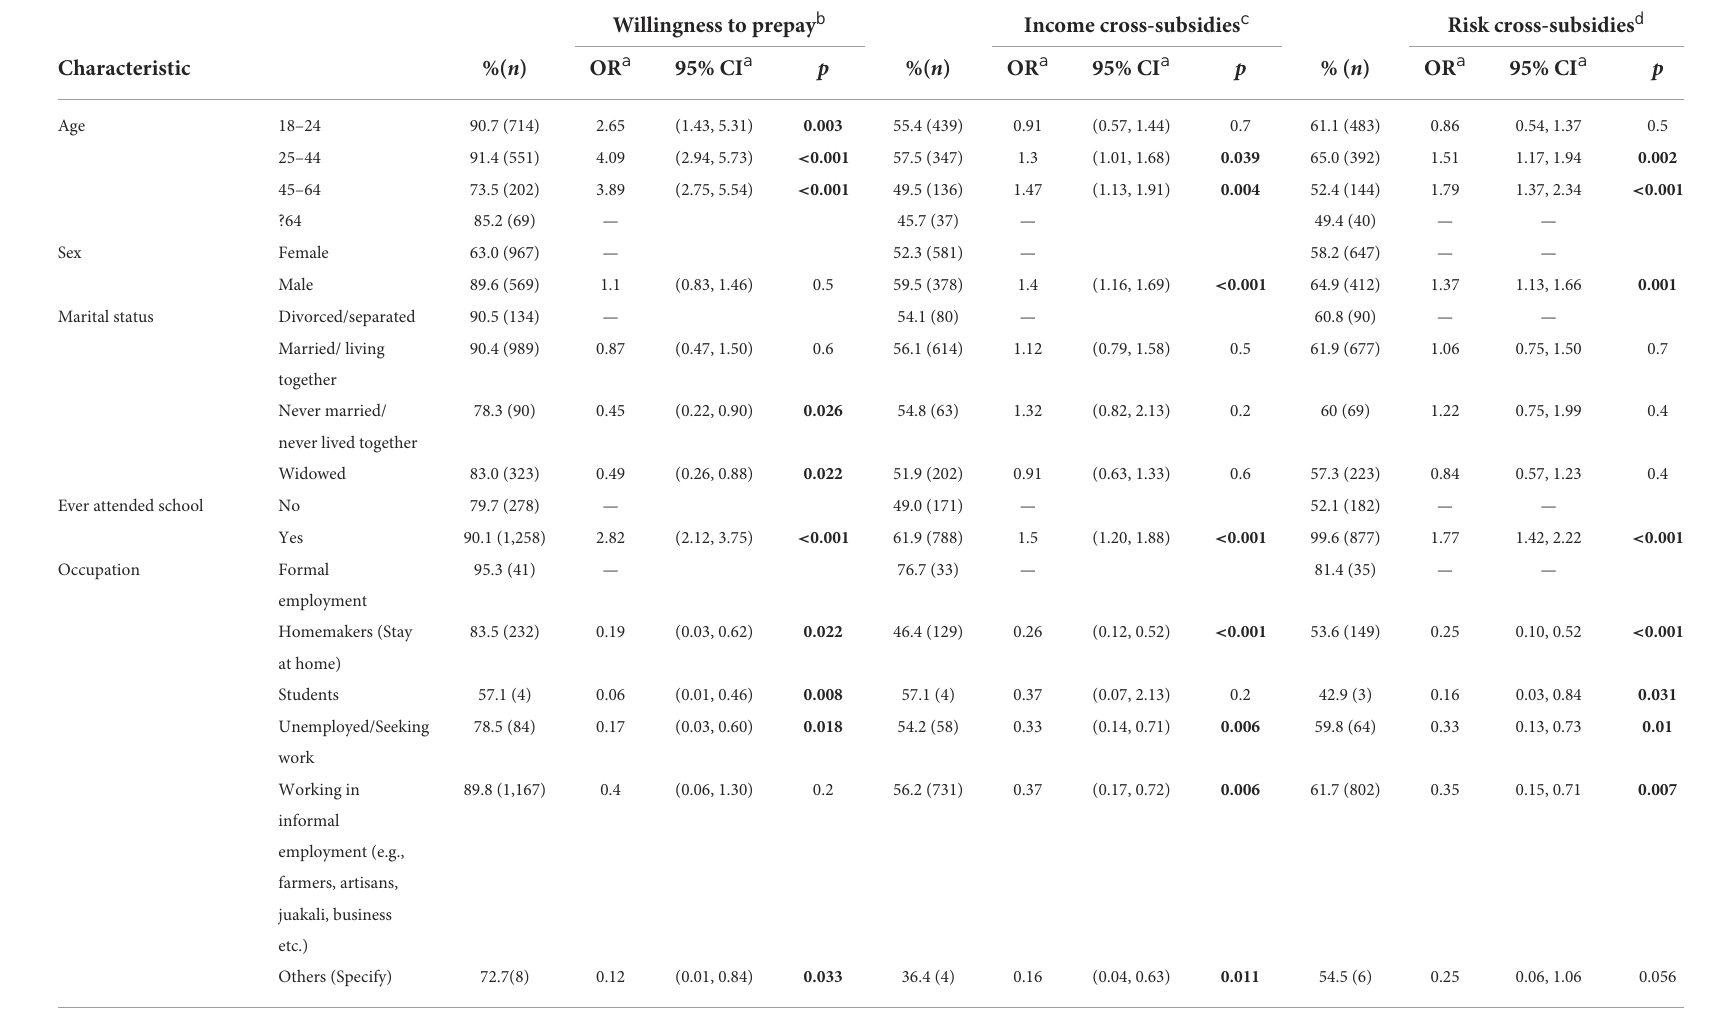
TABLE 2 Willingness to prepay and tolerance of risk cross-subsidies among the